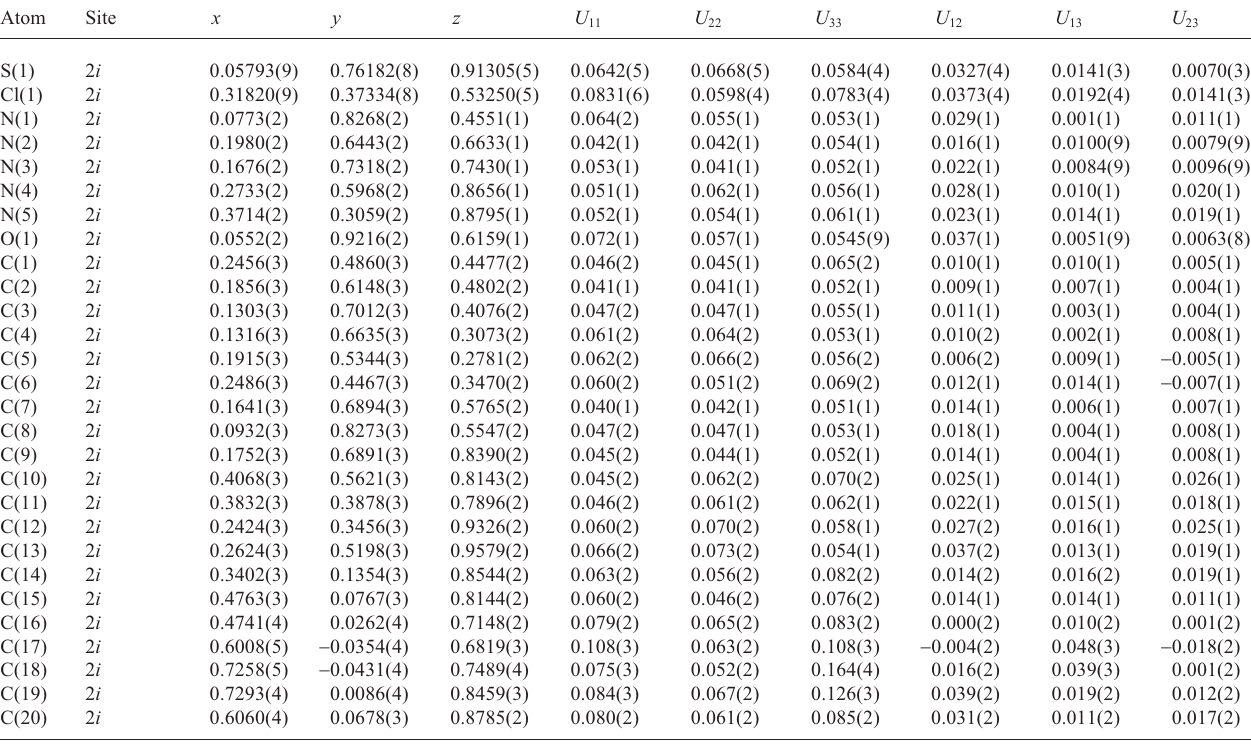
Table 3. Atomic coordinates and displacement parameters (in Å 2 )